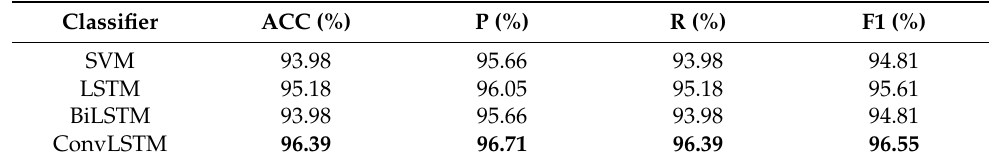
Table 2. Weighted average classification results.